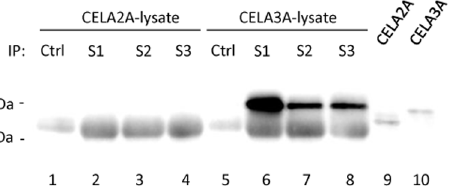
Fig 3. Immune precipitation of recombinant Elastase Isoforms CELA2A and CELA3A by rabbit antisera 1 – 3. HEK-293 cells were transiently transfected with Elastase-GFP-fusion constructs of elastase isoforms CELA2A and CELA3A. After 48h immune precipitations were performed from cell lysates with Elastase antisera 1 – 3 (S1-3) or Protein A sepharose alone (Ctrl). Total cell lysates are shown as an expression control (lane 9 – 10). Following SDS-Page, Western-blot detection was performed using anti-GFP